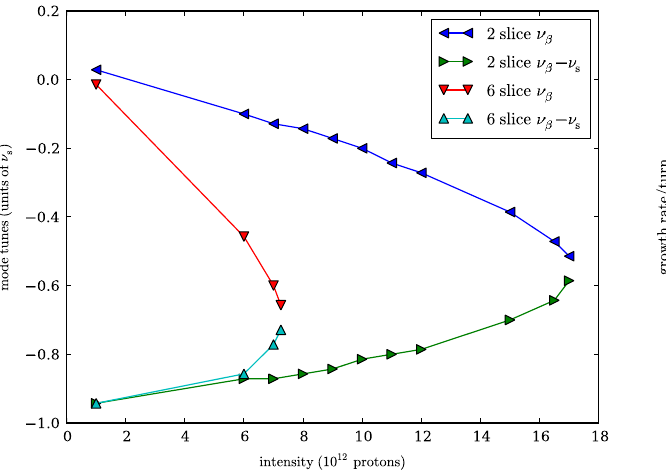
FIG. 4. (Color) Evolution of the base tune and lower synchro- betatron mode frequencies as a function of beam intensity showing the two modes approaching a common frequency due to impedance. The y scale is in units of the synchrotron tune. The simulations are shown for a two slice and six slice wakefield calculation.